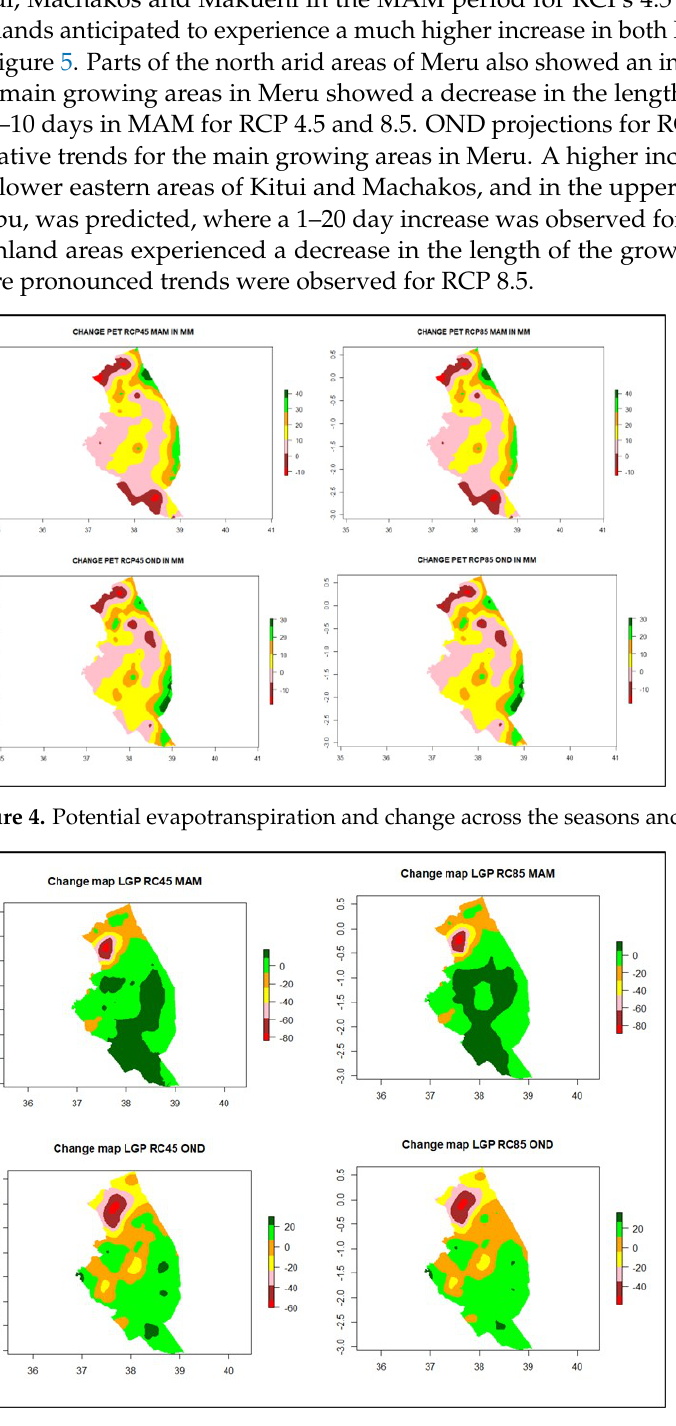
Figure 5. Changes in the length of growing days during MAM, OND in 2040 for RCPs 4.5 and